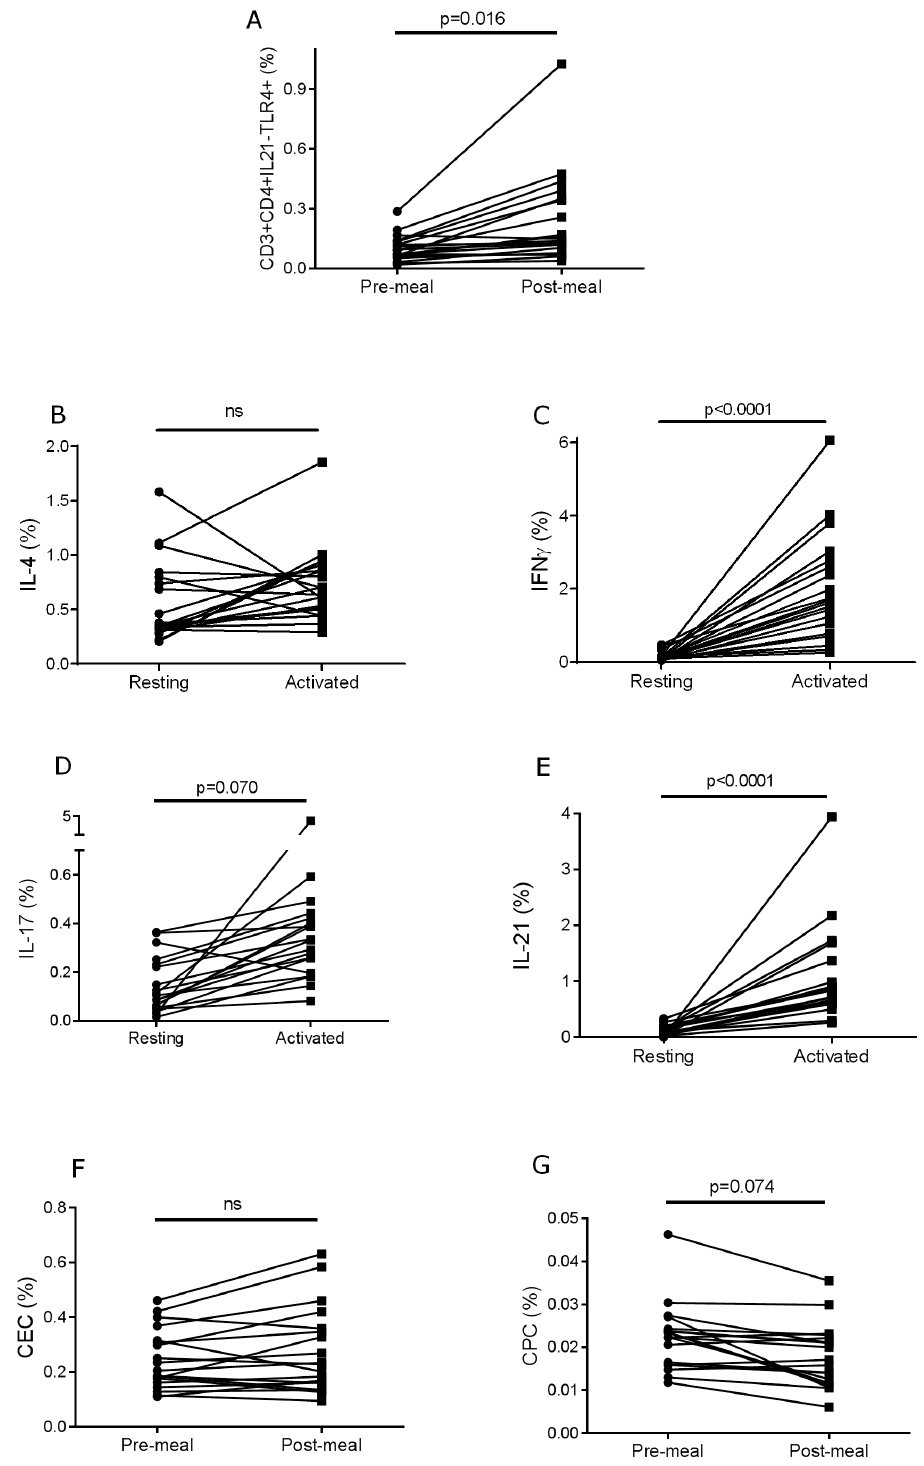
Figure 3. Frequency of TLR4 + T cells in peripheral blood before and 75 min post meal (A). Cytokine production in CD4 + T cells in peripheral blood before and after activation of the cells for 4 h ex vivo : IL-4 (B), IFN- c (C), IL-17 (D), IL-21 (E). Frequency of CECs (F) and CPCs (G) in peripheral blood before and 75 min post meal. Statistics was obtained using unpaired two-way T-test using Welsh correction. doi:10.1371/journal.pone.0107140.g003 CD133 and CD45 (Fig. 5A and C). The frequency of these cells expression of the stem cell marker CD34 together with CD45, CD31 and CD133 (Fig. 5A and B). The frequency of these cells food intake (Table 5, Fig. 3F). The CPCs were identified by was 0.02% of the peripheral blood (Table 5). Noteworthy, there